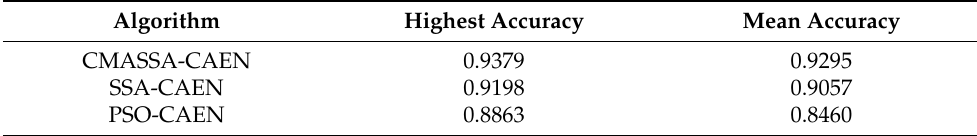
Table 9. The highest classification accuracy of the optimization algorithm on the